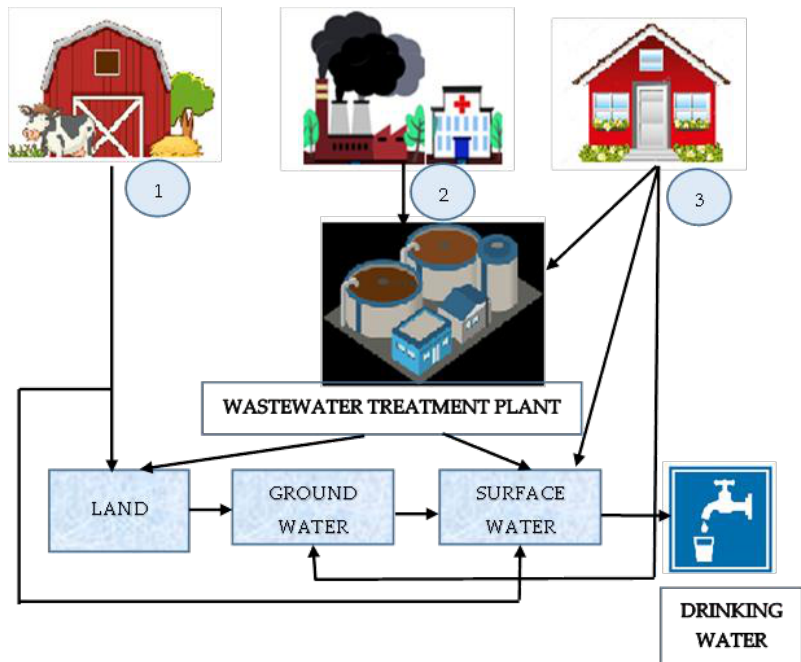
Figure 13. Potential sources of pharmaceutical pollution (modified from [147]): ( 1 ) animal husbandry; ( 2 ) industry and hospital; ( 3 ) household.